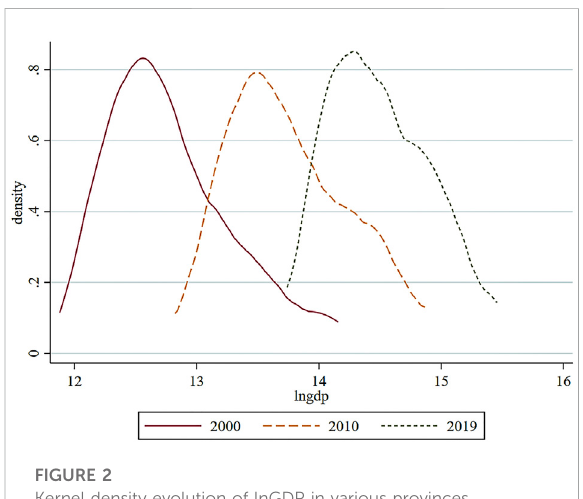
FIGURE 2 Kernel density evolution of lnGDP in various